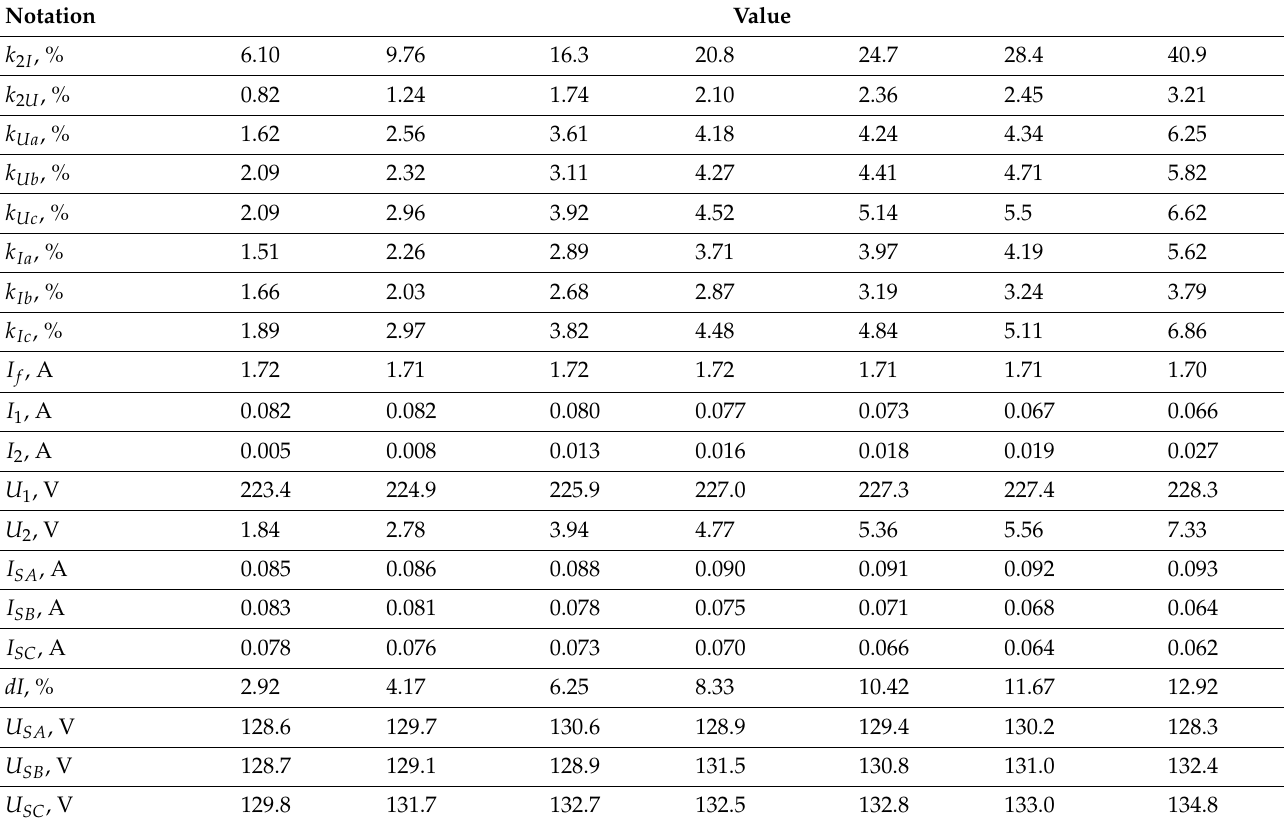
Table 3. Parameters of the physical model of the turbogenerator serving an unbalanced load.